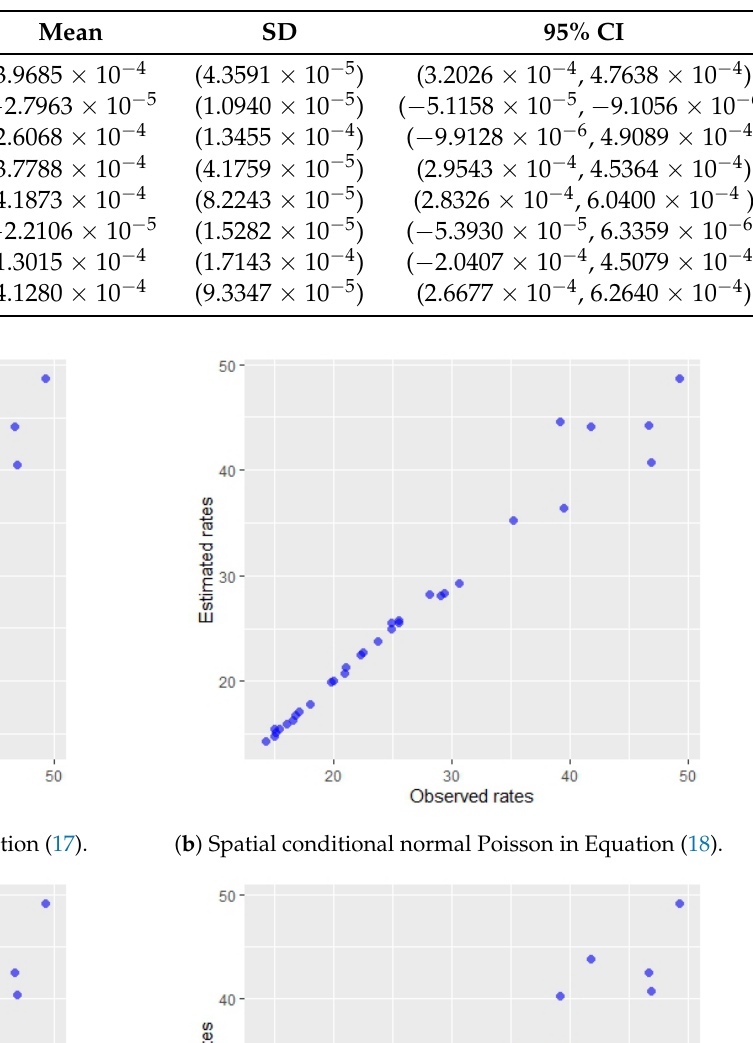
Table 10. Marginal effects at the means for some of the models fitted in Integrated Nested Laplace Approximation (INLA) to the Colombian infant mortality rates data set.